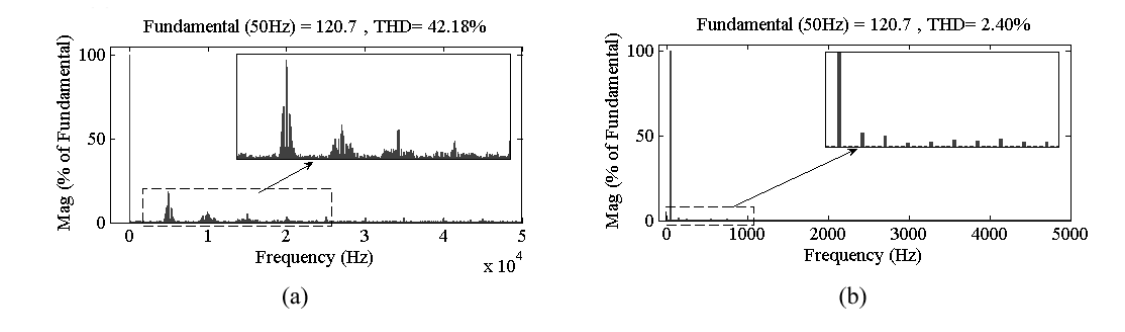
Figure 10. The FFT analysis result of the experimental prototype. ( a ) The stepped voltage u AB ; and ( b ) The output voltage u o .